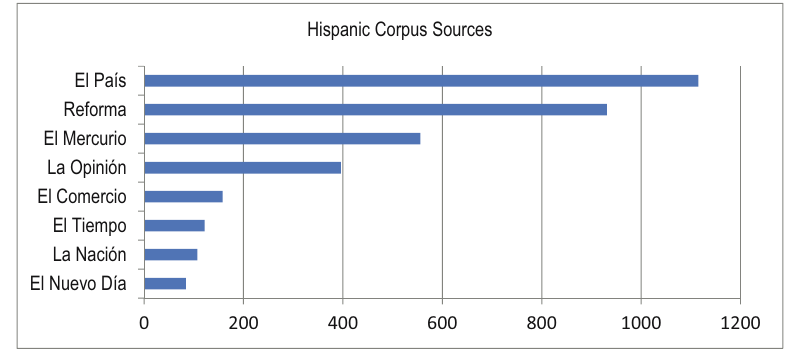
Figure 1: Number of pieces of each of the newspapers forming the Hispanic corpus.